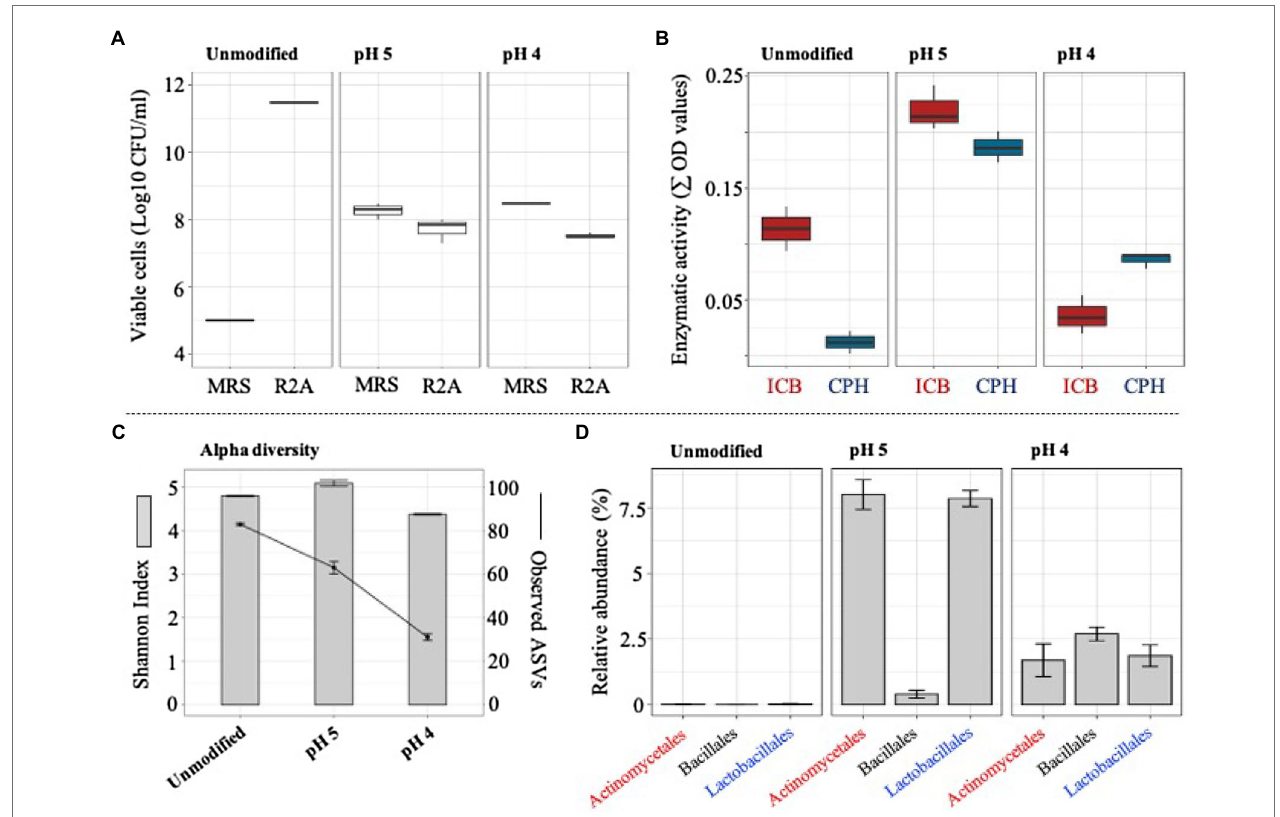
FIGURE 5 | Microbial growth, enzymatic activity, and structural composition of selected consortium (at T10) after its cultivation in lower pH values (unmodified, 5 and 4). (A) Viable cells (Log10 CFU/ml) of total and acid lactic bacteria quantified in agar R2A and MRS, respectively. (B) Secreted endo-enzymatic activities ( ∑ OD values) on six chromogenic polysaccharide hydrogels (CPH) and two insoluble biomass substrates (ICB) after T10 consortium growth on unmodified pH, pH 5, and pH 4. (C) Observed ASVs and Shannon index values. (D) Relative proportion of taxa (class) that increase their abundance at pH 5 and pH 4 (16S rRNA data). Error bars represent SDs from three biological